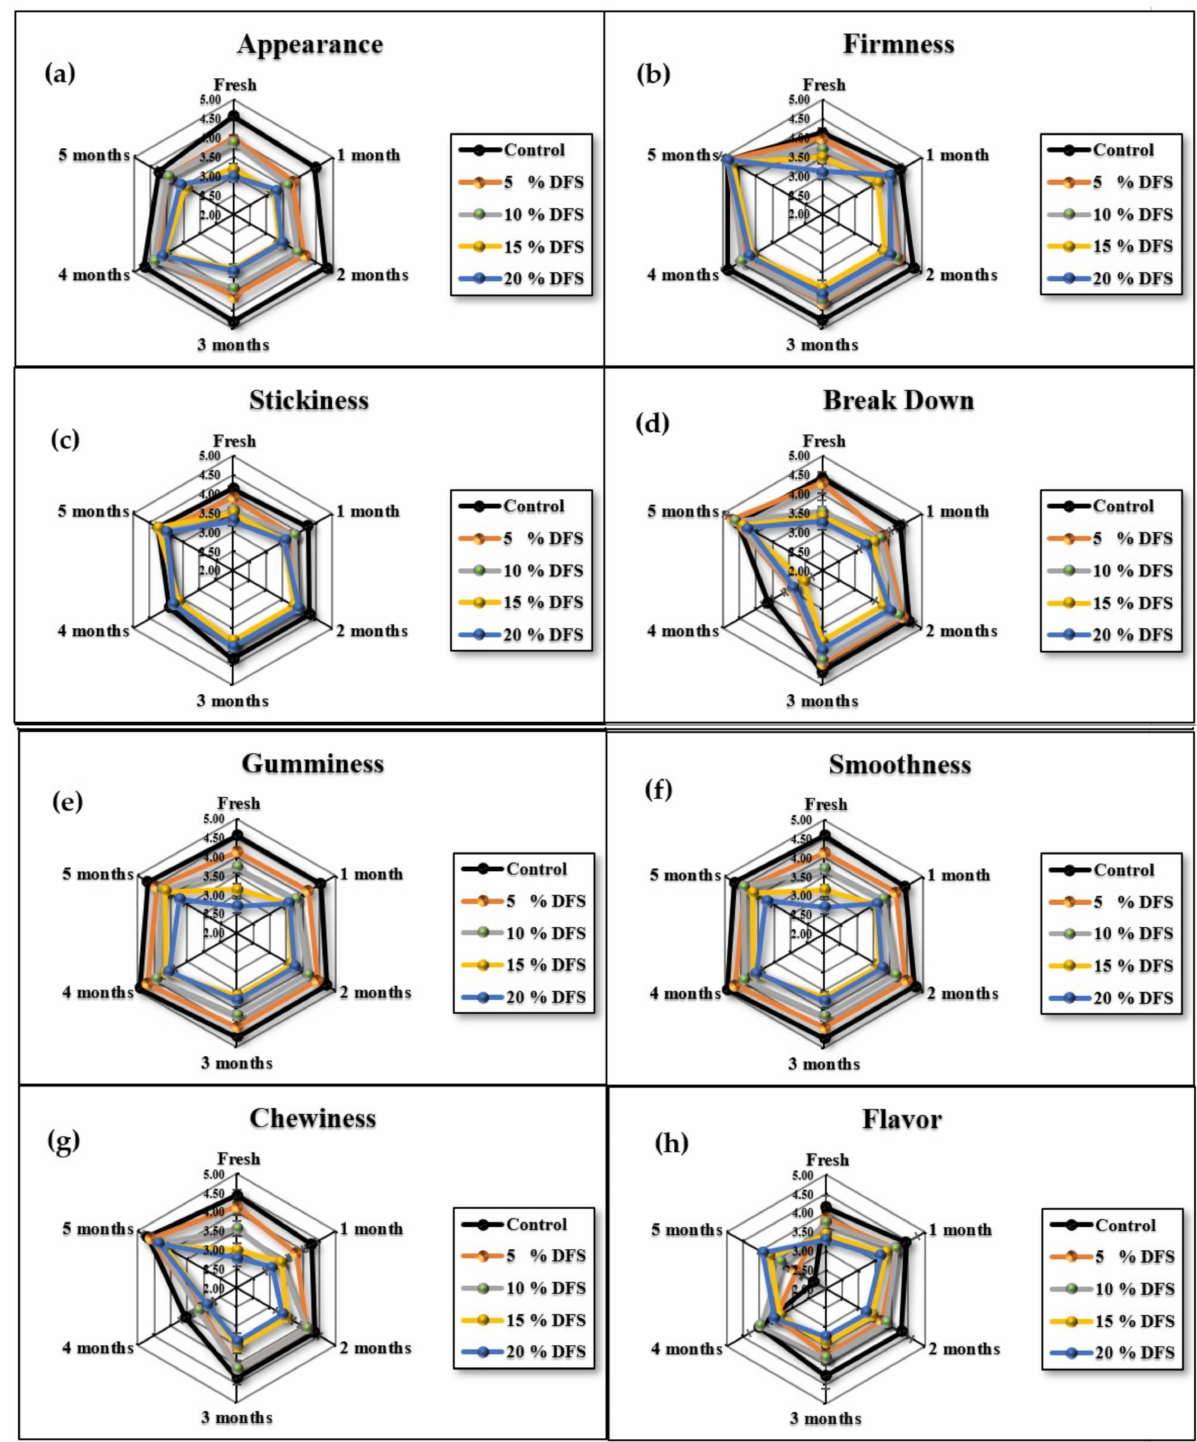
Figure 7. ( a – h ), Appearance, firmness, stickiness, breakdown, gumminess, smoothness, chewiness, and flavor of cheeses fortified with 5%, 10%, 15%, and 20% DFS as a partial substitution for butter during